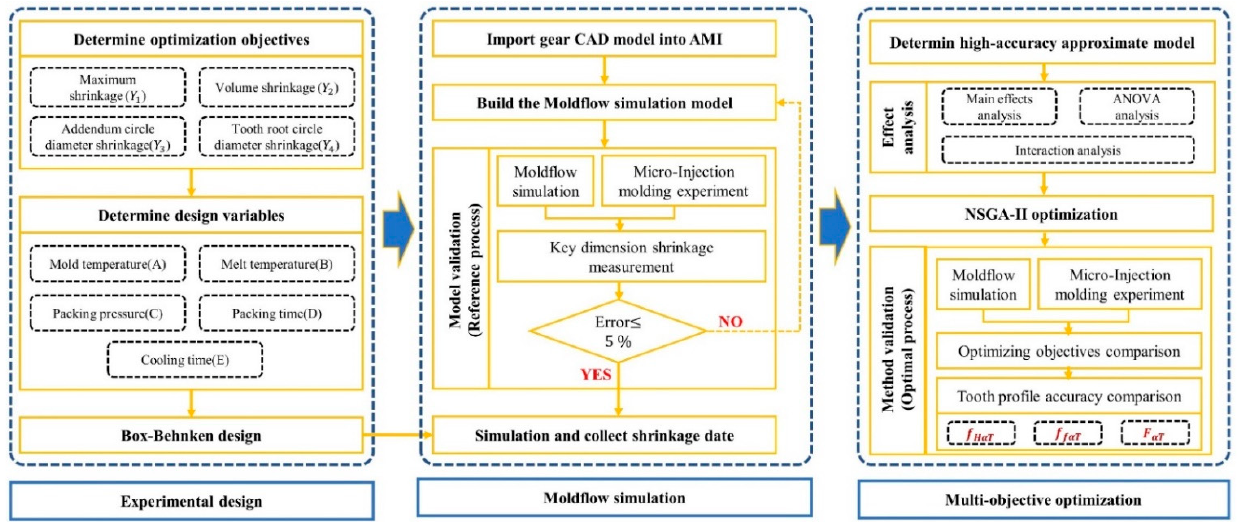
Figure 1. The tooth profile accuracy improvement method for micro ‐ injection molded small ‐ module plastic gears.